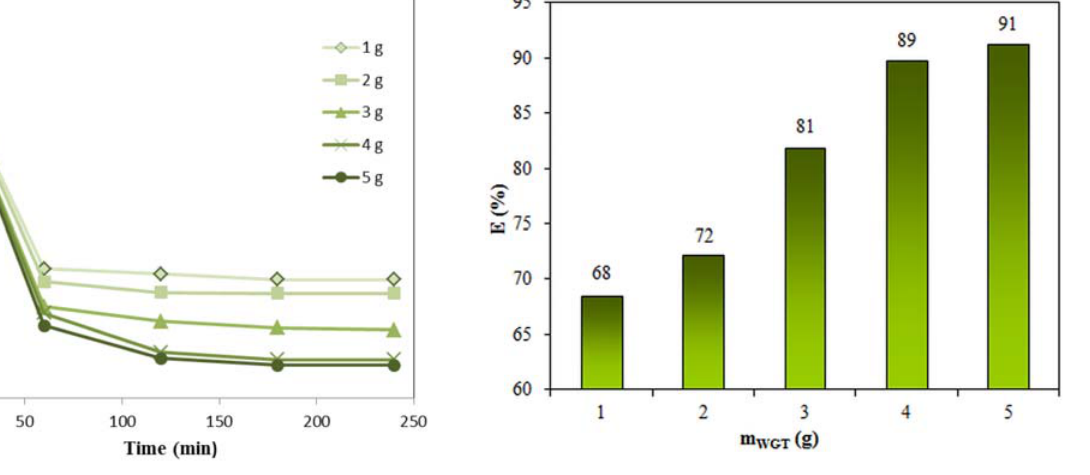
Figure 3. The effect of untreated WGT quantity over the adsorption efficiency (296 K, 94 mg/L, 100 mL, 200–400 μm, 300 rpm, 240